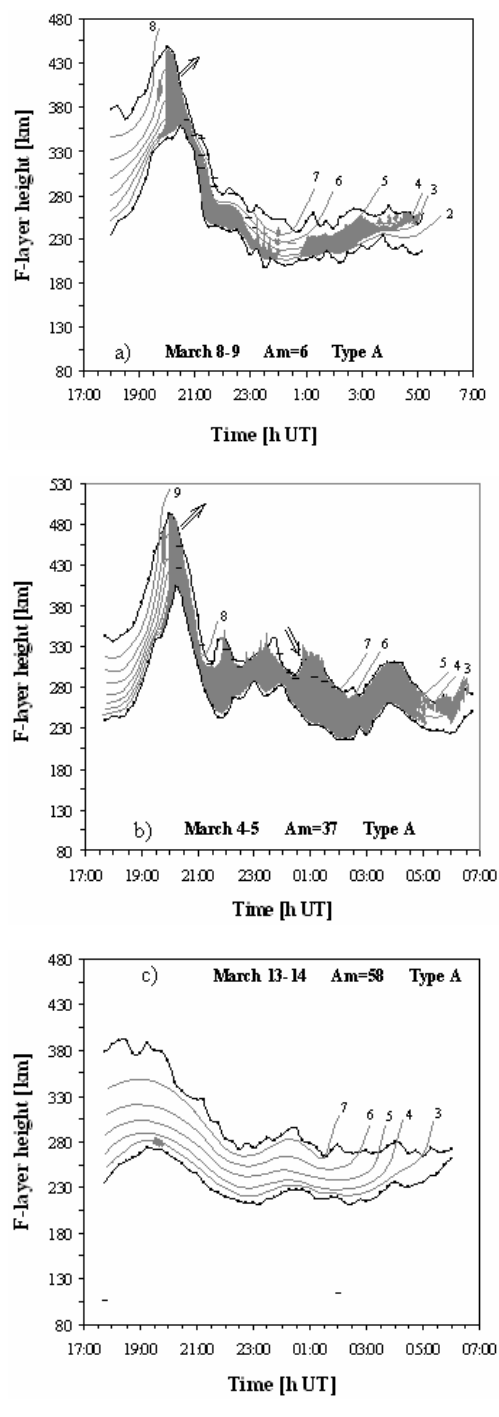
Fig. 6. ESF behaviour on A-type F-layers for three nights, (a) 8–9 March, (b) 4–5 March, (c) 13–14 March; The X axis corresponds to UT time, the y-axis to the F-layer height in kilometres, the grey area to the ESF pattern, the grey lines to the isofrequency lines (the numbers indicate their values in MHz). The outward arrows direct the development of the P-type ESF and the inward ones indicate immerging